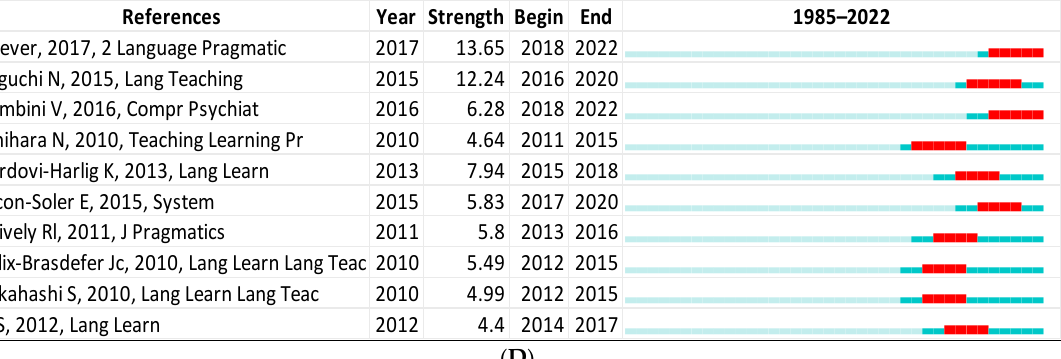
Figure 13. Top 10 cited authors and references with the strongest citation bursts: ( A ) Scopus [16,67,86, 111,128,140,142,144–146]; ( B ) Scopus [51,91,147–153]; ( C ) WOS [8,50,92,118,129,131,132,136,138,139]; ( D ) WOS [147,148,150,151,153–157].